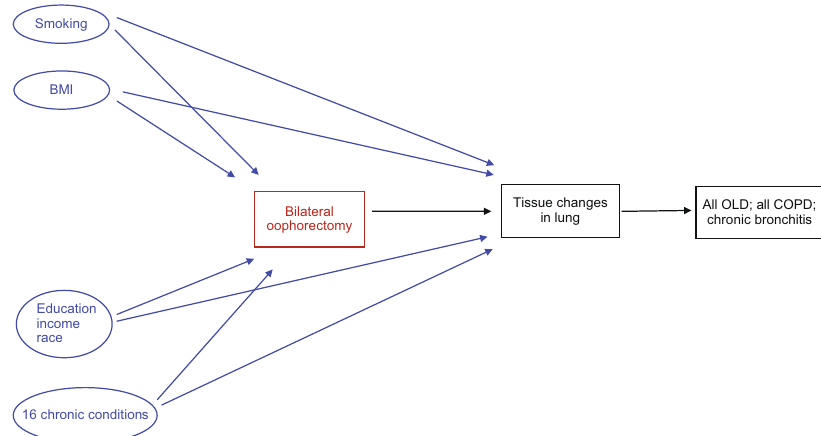
Fig. 4 Causal diagram. Possible confounding effect of the variables included in the inverse probability weighting. Smoking and obesity were also considered as effect modi fi ers and strati fi ed analyses were reported. BMI body mass index, COPD chronic obstructive pulmonary disease, OLD obstructive lung disease.